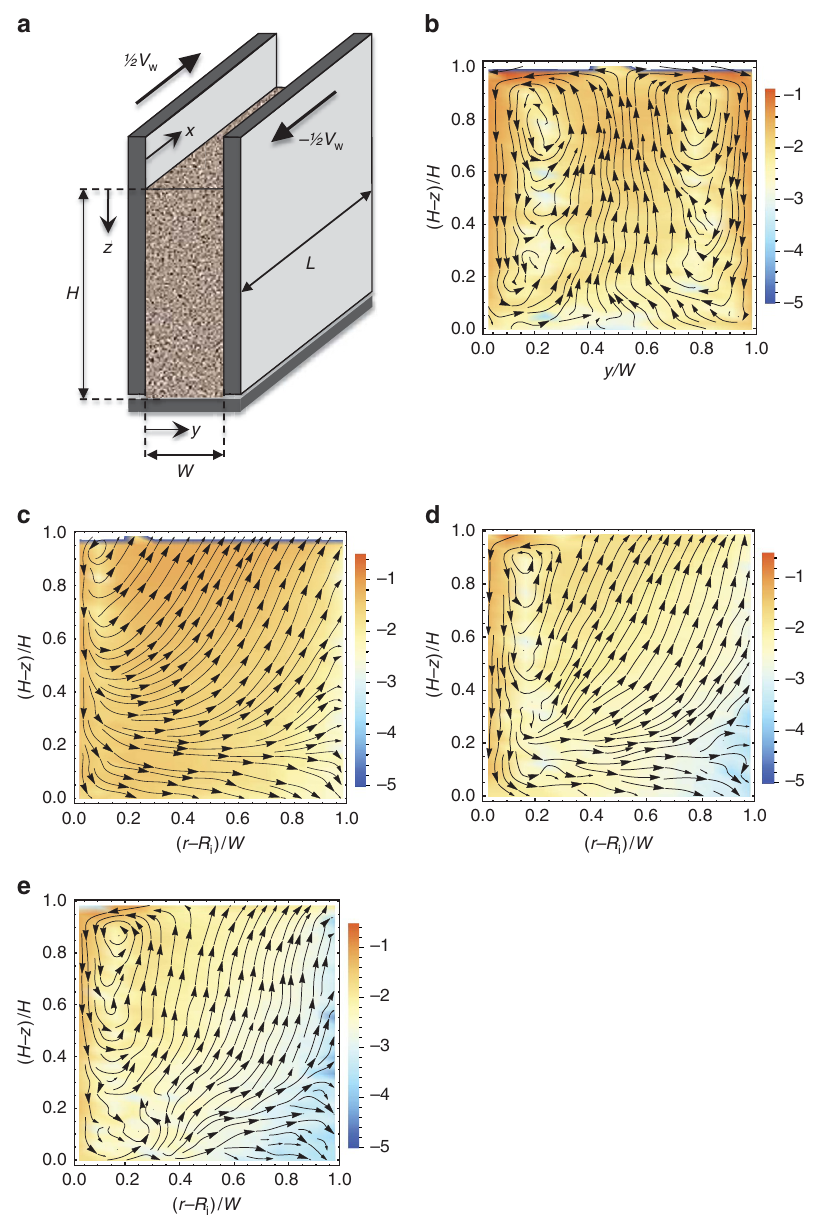
Figure 5 | The cause of the secondary vortex. ( a ) Schematic diagram of plane shear between vertical walls. ( b ) Streamlines of the secondary flow in plane shear. The unit cell of dimensions W ¼ 16 d p , H ¼ 30 d p and L ¼ 50 d p is replicated periodically in the x direction. ( c – e ) Transient evolution of the secondary flow in a cylindrical Couette cell after initiation of shear: the streamlines after an inner cylinder rotation of 3.4 (cid:2) ( c ), 22 (cid:2) ( d ) and 45 (cid:2) ( e ). The background (cid:2) (cid:3) 1 = 2 = V v 2 colour indicates the value of log 10 s , where s (cid:5) v 2 w is the magnitude of the secondary flow. In c – e the Couette cell is filled by the dense packing r þ z method to a fill height H ¼ 30 d p and the walls are rough; the velocity fields are averaged over the preceding 3.4 (cid:2) in ( c ) and 8 (cid:2) in ( d , e